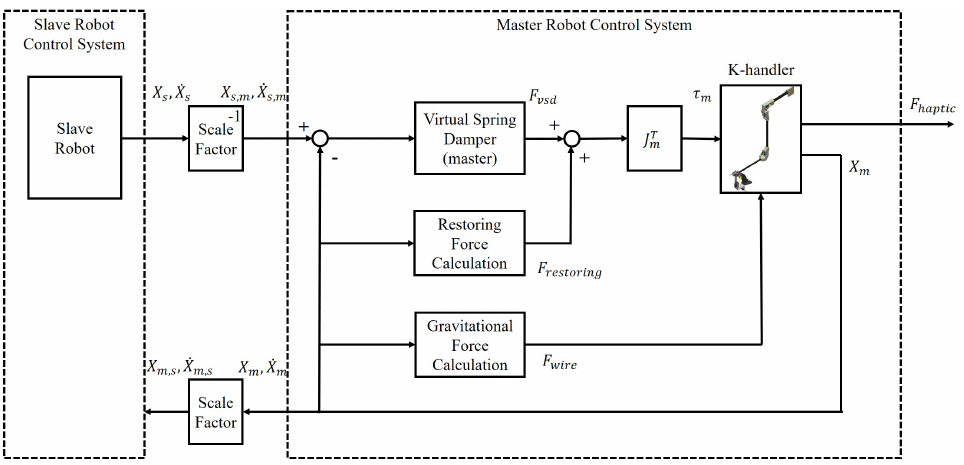
Figure 9. The control architecture of the